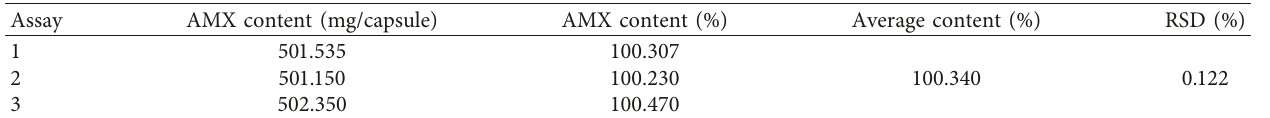
Table 5: Determination of amoxicillin in the